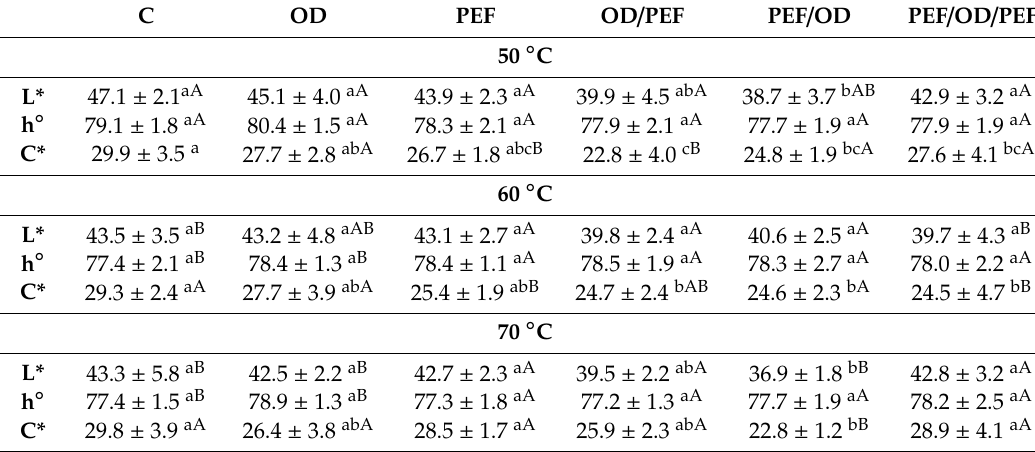
Table 3. Color parameters (L*—luminosity, h ◦ —hue angle, C*—chroma) of untreated and di ff erently pre-treated kiwifruit snacks dried at the temperatures of 50, 60 and 70 ◦